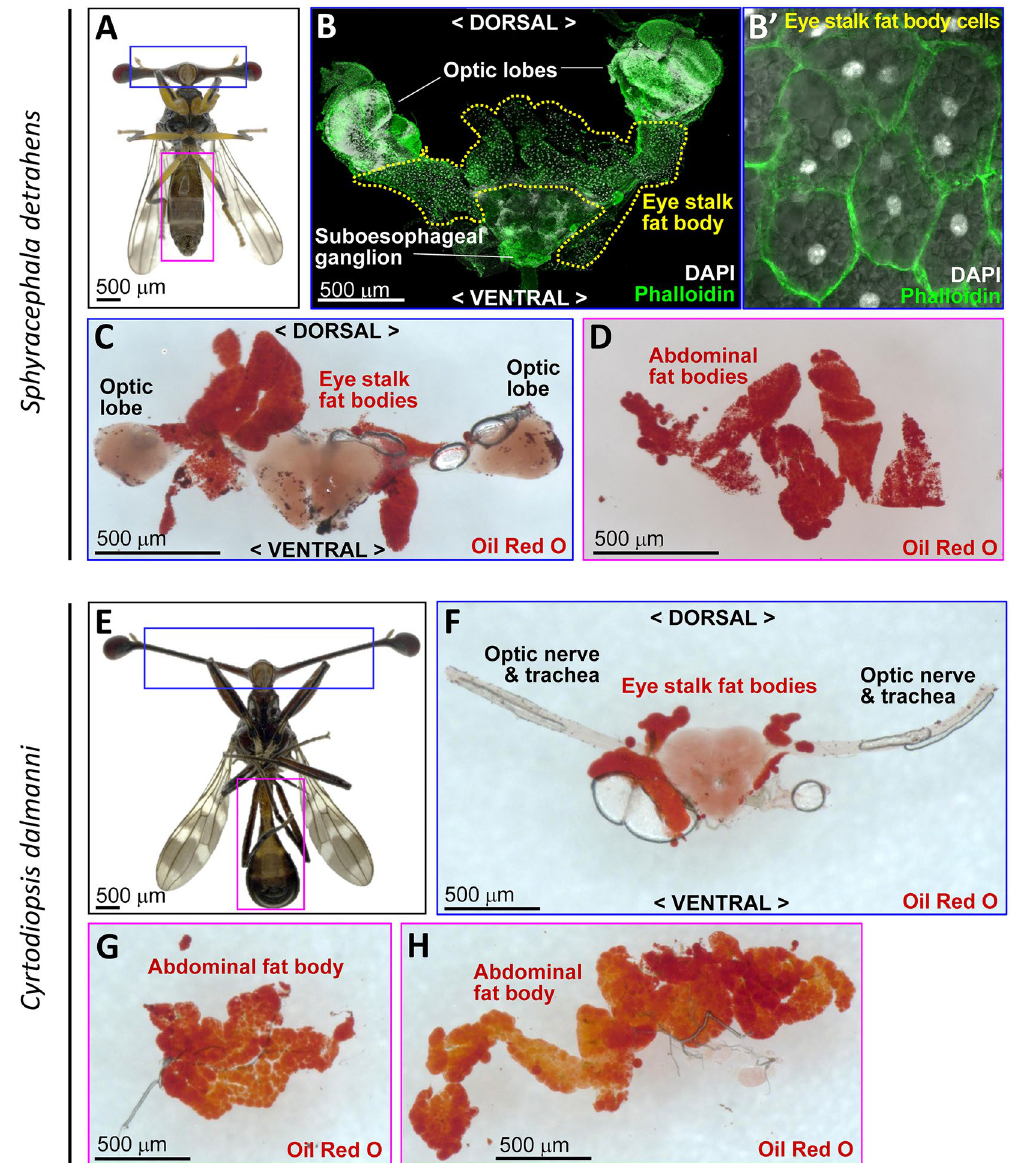
Figure 1. Difference in the volume of fat bodies in eye stalks between two stalk-eyed fly species: S. detrahens and C. dalmanni . ( A – D ) S. detrahens. ( A ) Ventral view of an adult male. ( B ) Eye stalk fat body (outlined by the yellow dotted line) present along the optic nerve bundle dissected from the blue-boxed region in ( A ). White: DAPI showing nuclei, green: phalloidin showing filamentous actin. ( B ′ ) High magnification image of binucleate cells in the eye stalk fat body merged with a differential interference image showing multiple lipid droplets in the cytoplasm. Phalloidin-stained filamentous actin-associated plasma membranes. ( C ) Eye stalk fat body stained with oil red O (brownish-red). ( D ) Abdominal fat body dissected from the magenta-boxed region in A and stained with oil red O. ( E – H ) C. dalmanni. ( E ) Ventral view of an adult male. ( F ) Eye stalk fat body dissected from the blue-boxed region in E and stained with oil red O. ( G , H ) Small and large examples of an abdominal fat body dissected from the magenta-boxed region in E and stained with oil red